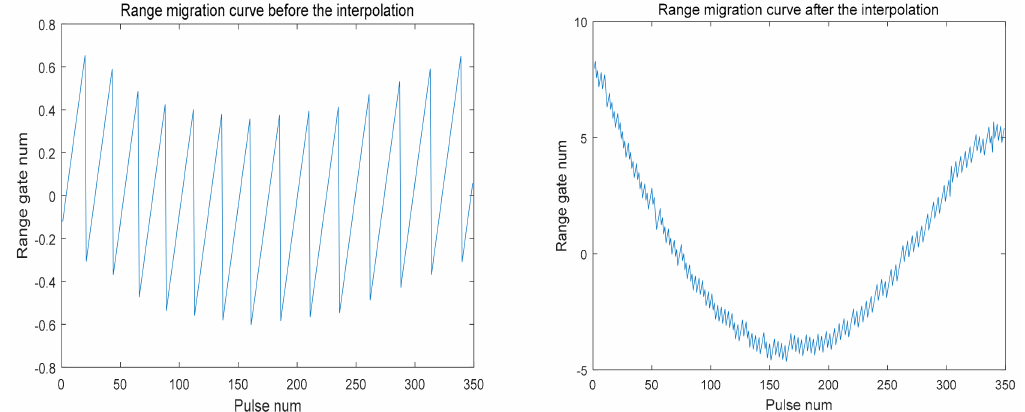
Figure 10. The comparison of the range migration curves before and after